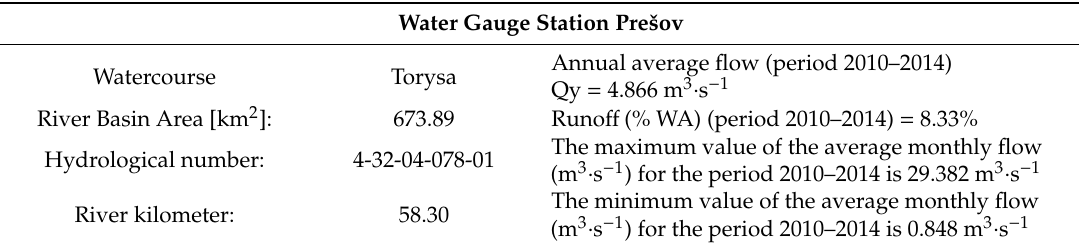
Table 1. General information about the state of the monitoring station of the observed area (Data from